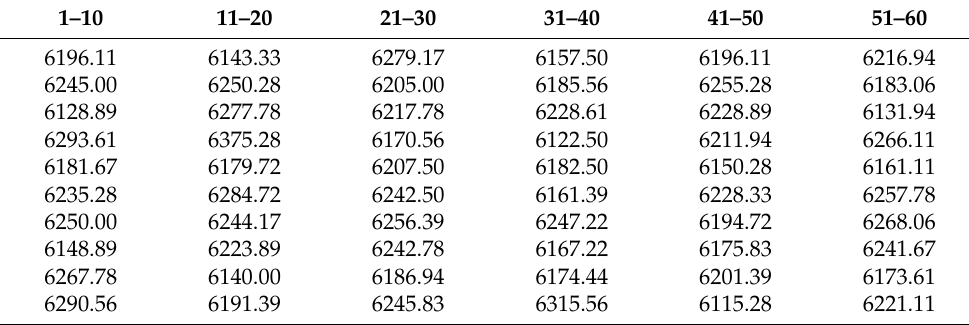
Table 1. The first to the sixtieth flow data of supply water (m 3 /h).